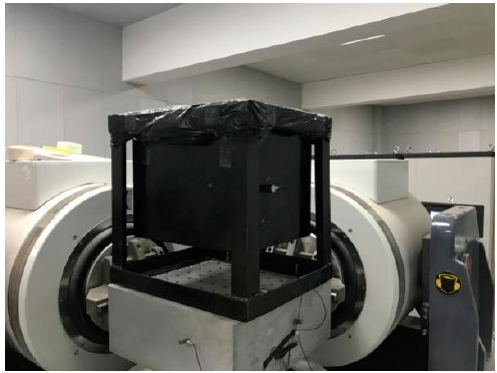
Figure 2. Schematic diagram of the test platform and model installation.